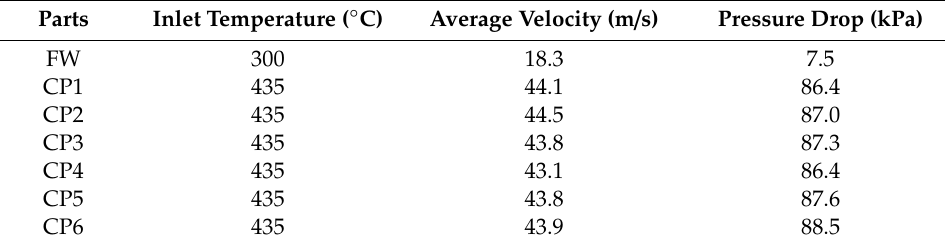
Table 3. Boundaries conditions adopted in the thermal-hydraulics calculation.